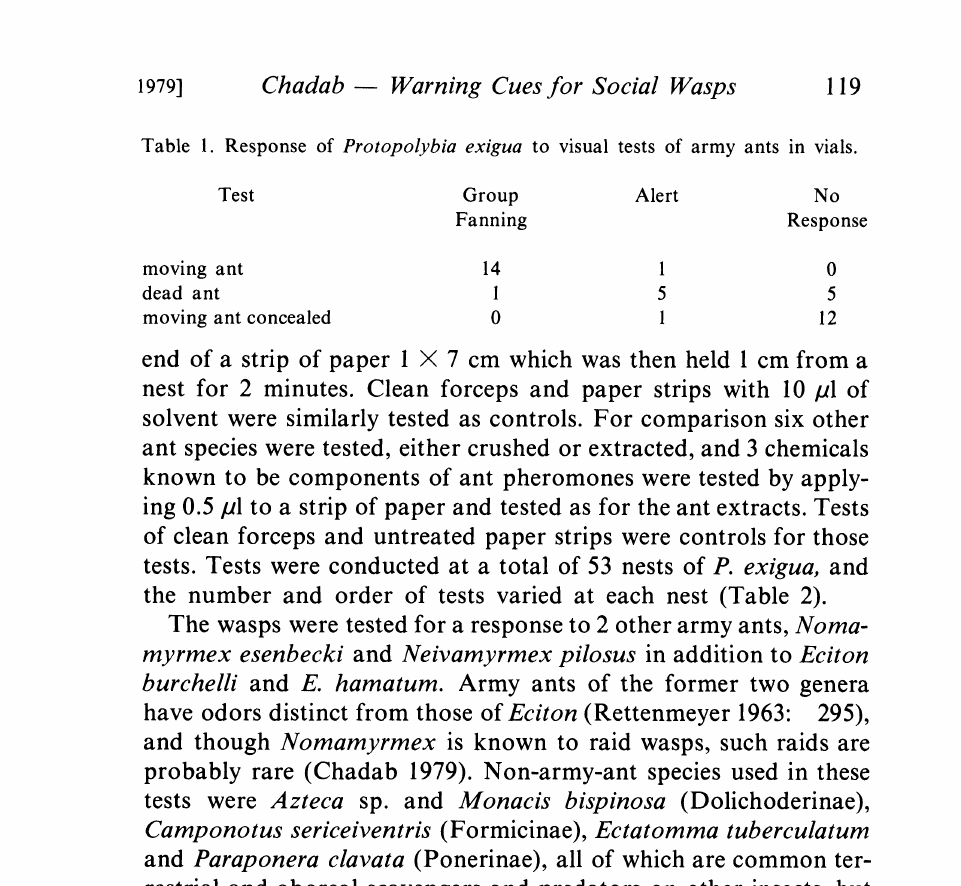
Table 1. Response of Protopolybia exigua to visual tests of army ants in